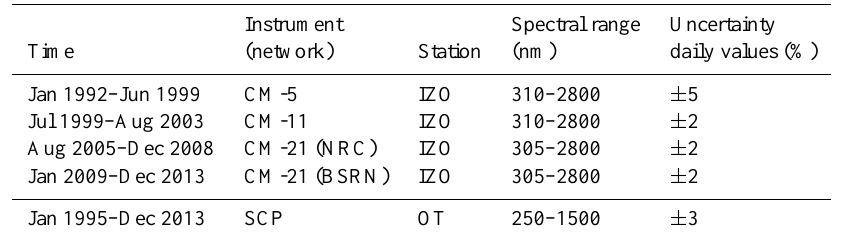
Instrument Spectral range Uncertainty (network)